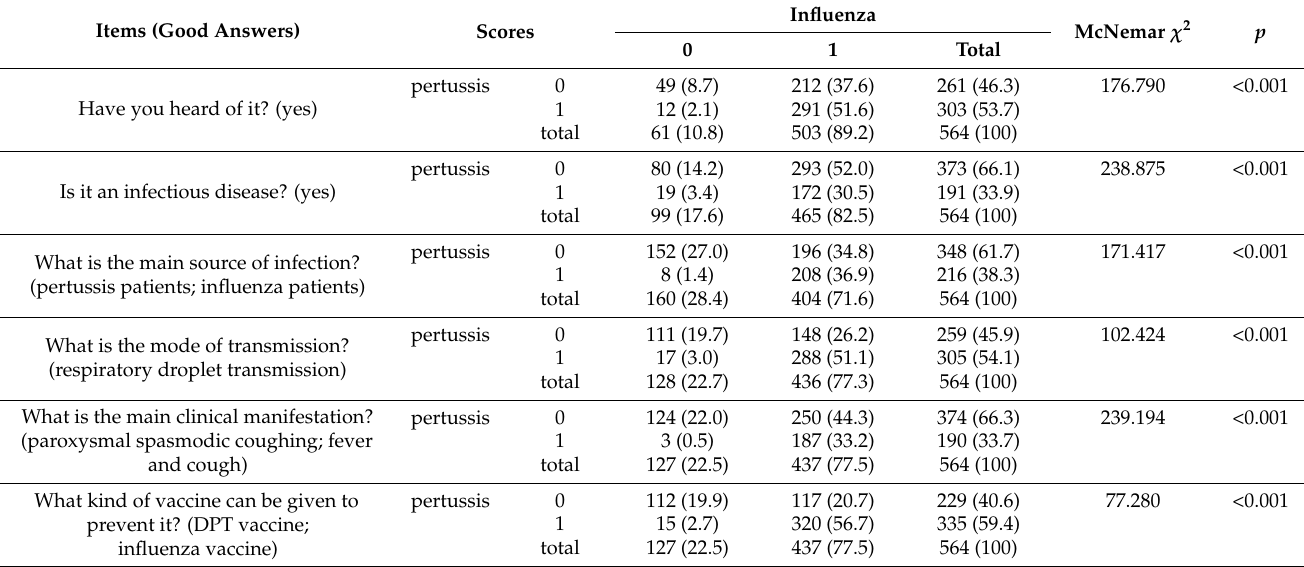
Table 2. Knowledge of pertussis and influenza prevention and control among pregnant women n